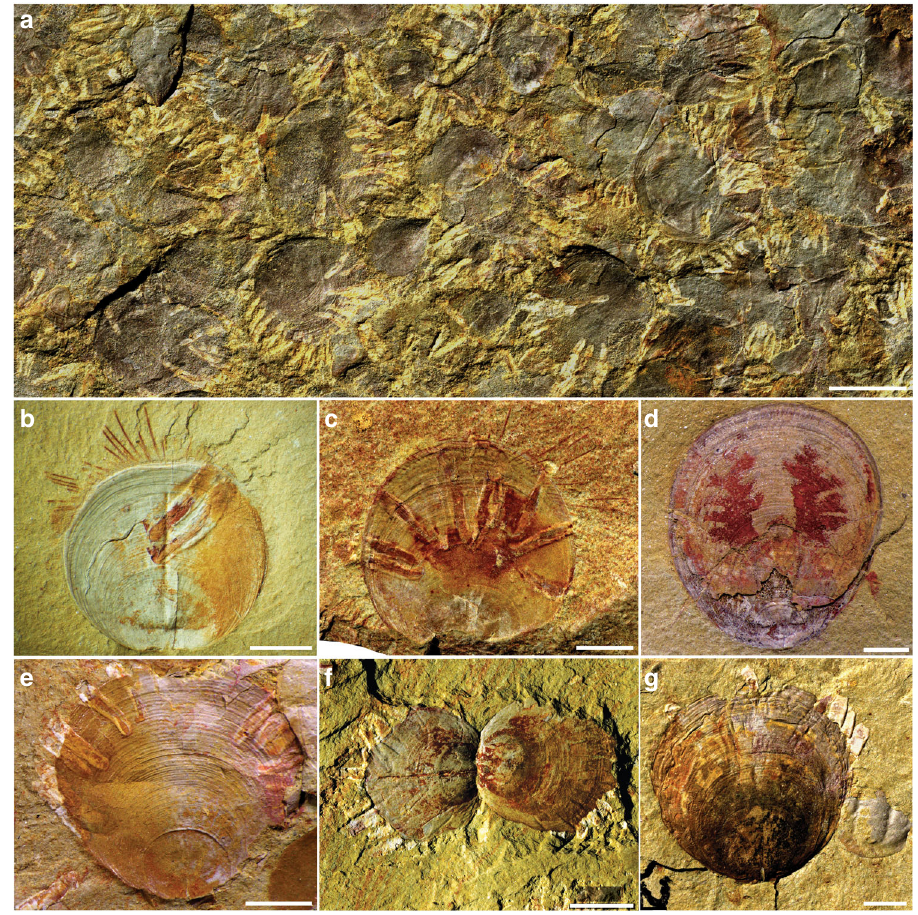
Fig. 1 The brachiopod Neobolus wulongqingensis sp. nov., with associated obligate, encrusting kleptoparasitic tubes. a ELI GB-N-0301, densely aggregated valves of N. wulongqingensis forming distinctive shell beds with their associated kleptoparasites. Scale bar 4 mm. b , c Specimens of N . wulongqingensis with varying numbers of encrusting kleptoparastic tubes (see Supplementary Note 1 for details); b ELI GB-N-0650, c ELI GB-N-0648-5. d ELI GB-N-0008, N . wulongqingensis with baculate mantle canals preserved. e ELI GB-N-0261-18, N . wulongqingensis with encrusting kleptoparastic tubes. f ELI GB-N-0255-6, internal view of a pair of conjoined valves with kleptoparasitic tubes encrusted to both valves g ELI GB-N-0869-2-1. N . wulongqingensis with encrusting kleptoparasitic tubes and trilobite cranidium (exuviae) lacking attached tubes. Scale bars 2 mm, unless otherwise